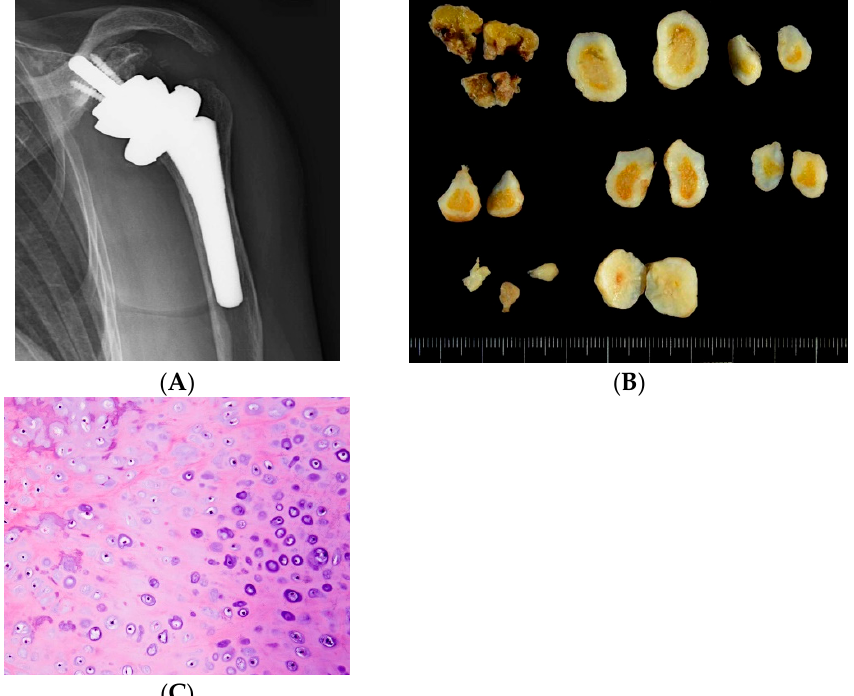
Figure 2. Postoperative evaluation. ( A ) Postoperative X-ray. After reverse shoulder arthroplasty, the mass in the shoulder joint has disappeared, and the course is favorable; Pathologic findings. ( B ) On a cut surface, the surface was covered with whitish cartilage, while the center consisted of yellowish bone tissue. ( C ) The histological picture showed a nodular mass covered with hyaline cartilage. In the center of the cartilage, ossification was present. No findings of malignancy were seen. Lammification structure of the hypertrophic chondrocyte was observed on the surface of the lesion, which led to the diagnosis of primary osteochondroma.